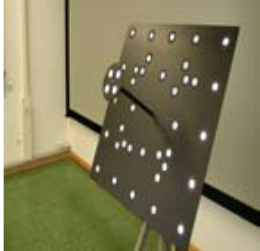
Fig. 1. Test-field for the camera calibration